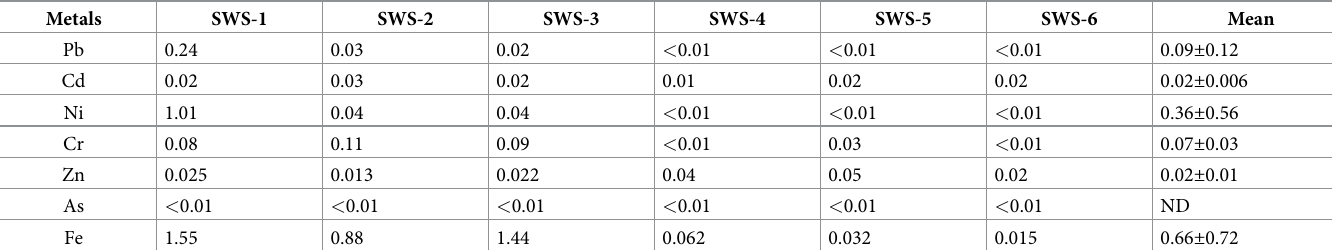
Table 4. Heavy metal concentrations (mg/L) in landfill impacted surface water during the wet season.